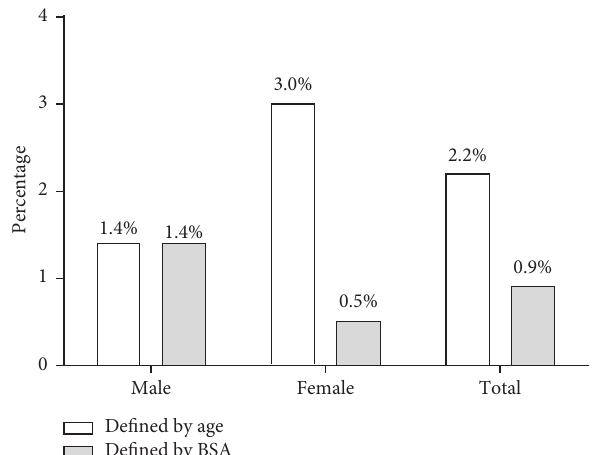
Figure 4: Prevalence of goitre defined by age and BSA among male and female school-aged children (6–12 years) in the Ashanti region of Ghana.